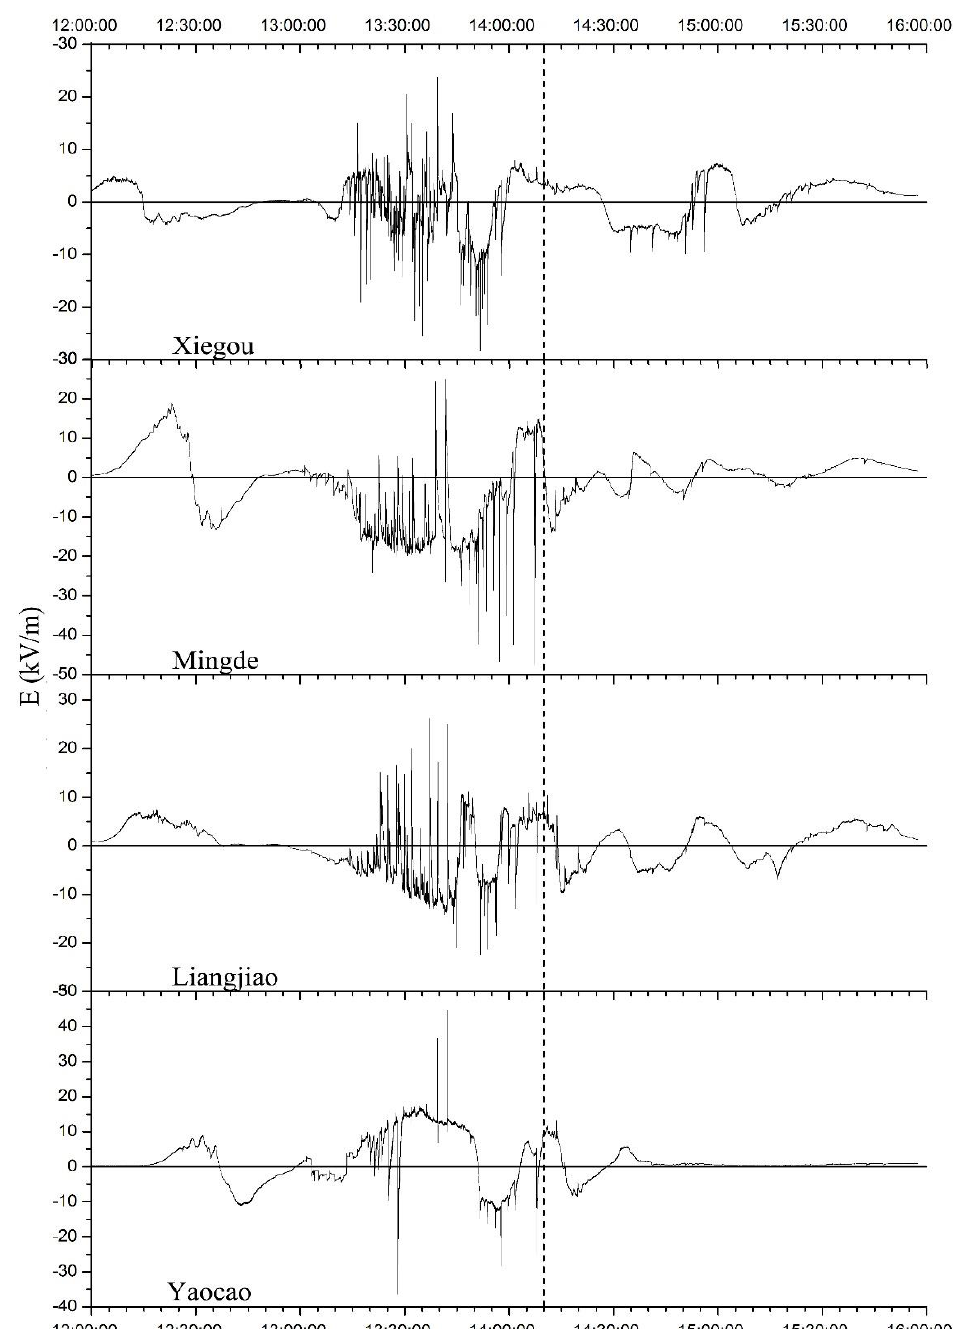
Figure 13. Ground electric field change waveform of four stations, with vertical dashed lines indicating the hailfall time. Before and after hail, the trend of change in the ground electric field reversed.